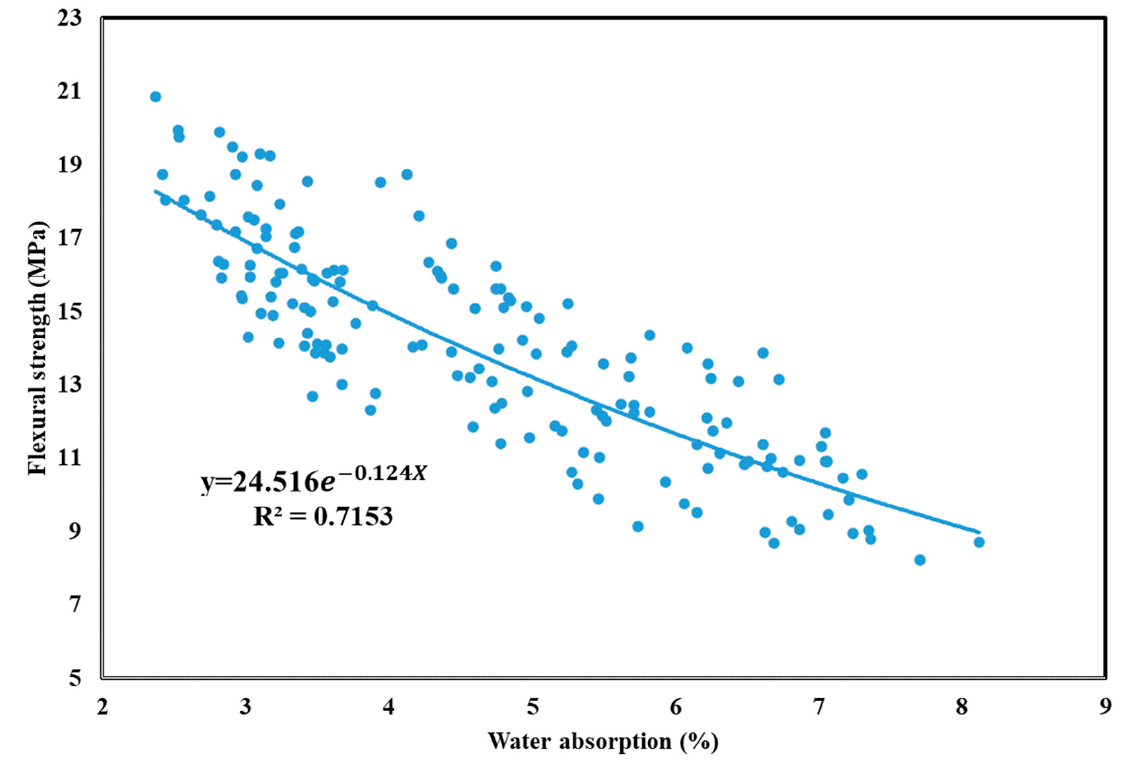
Figure 15. Regression analysis of flexural strength and water absorption of green and ecofriendly grouting material.